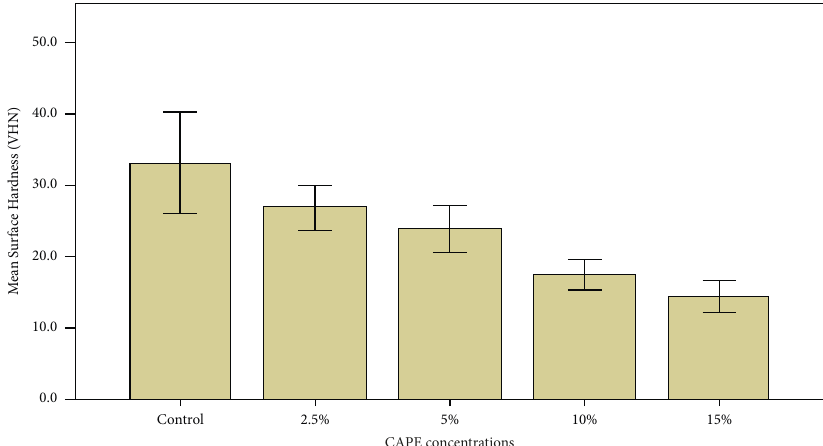
Figure 3: Effect of CAPE concentration on denture acrylic base presented by mean surface hardness (VHN).